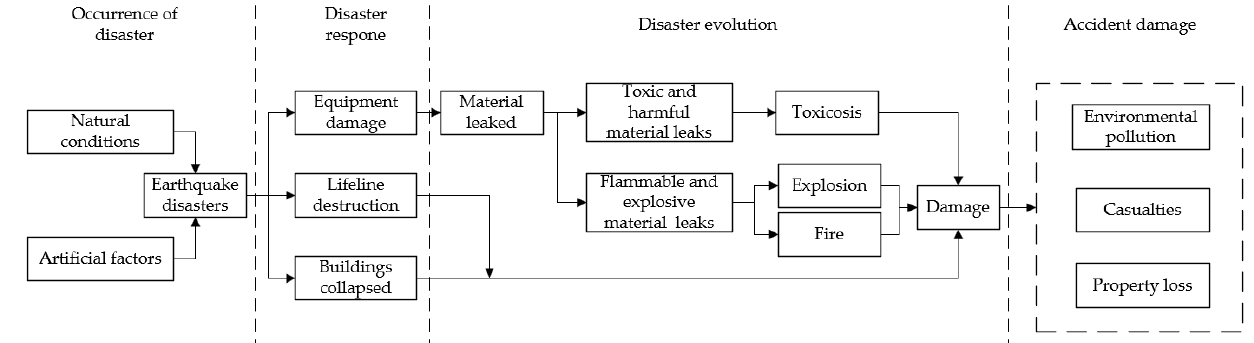
Figure 4. Mechanism diagram of the earthquake disaster in the chemical industrial park. Table 2. Event sets.